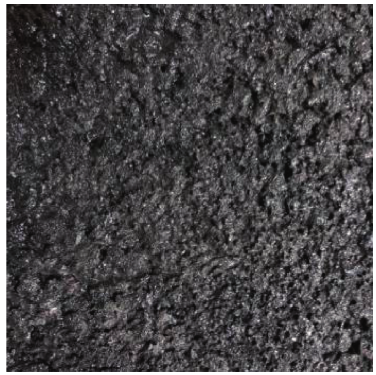
Figure 9: One asphalt one